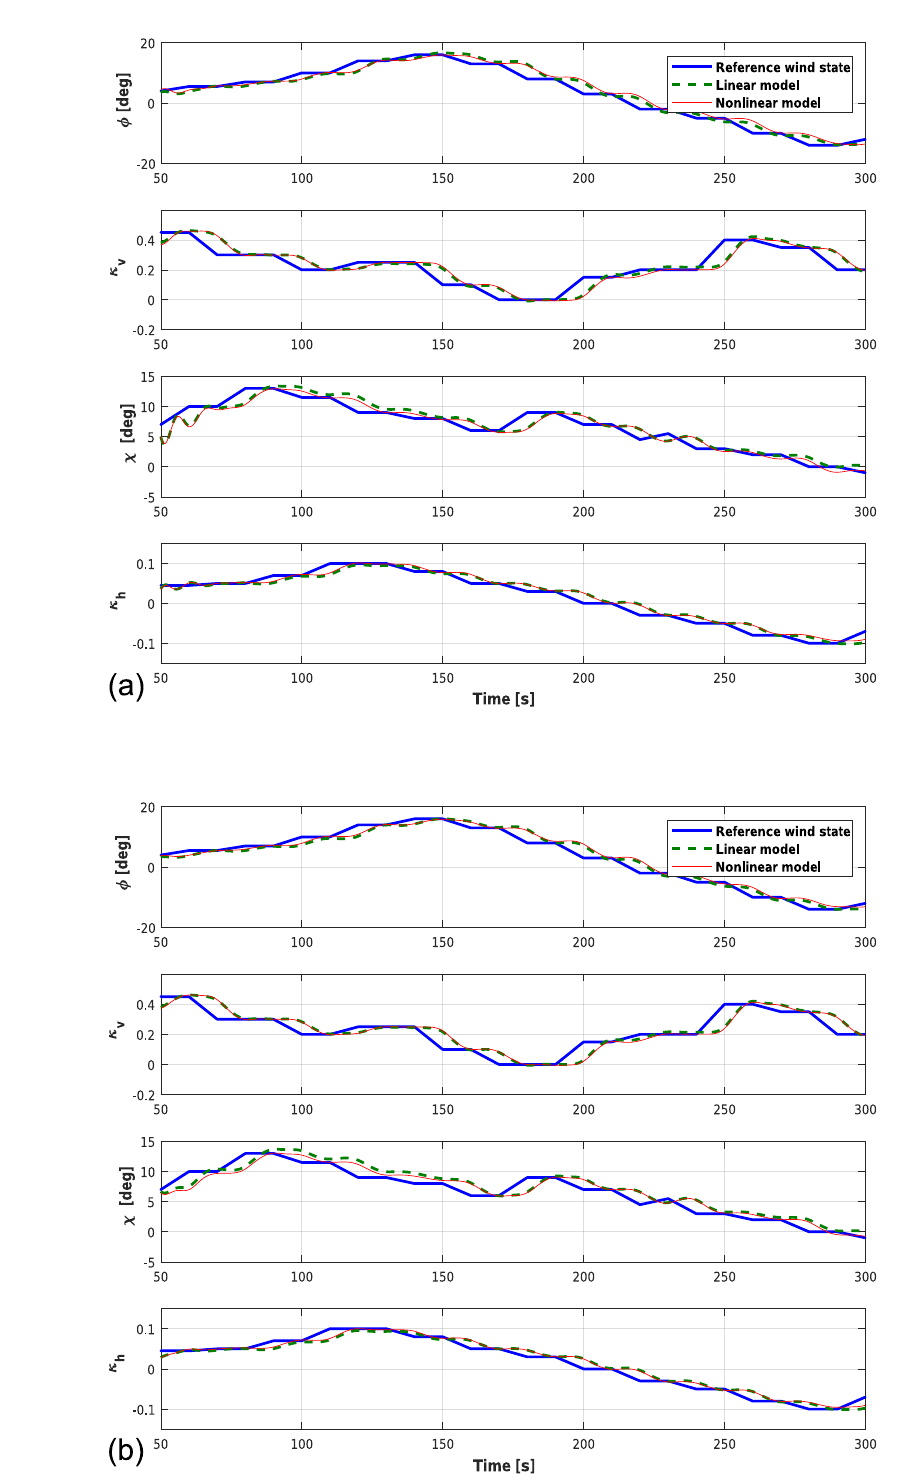
− Figure 11. Wind state observations in nonturbulent wind conditions with variable wind parameters at 4 (a) and 9ms − 1 (b) . Solid thick blue